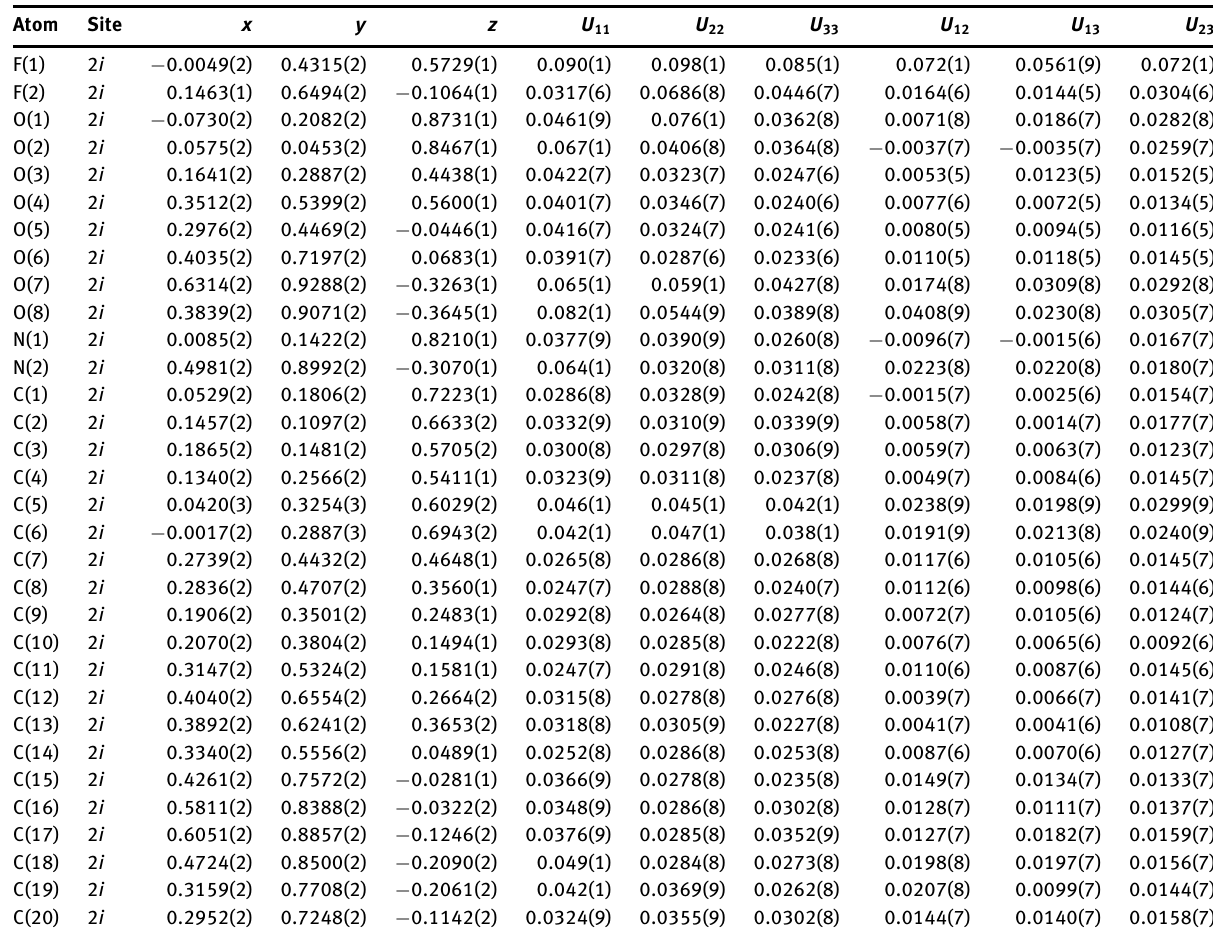
Table 3: Atomic displacement parameters (Å 2